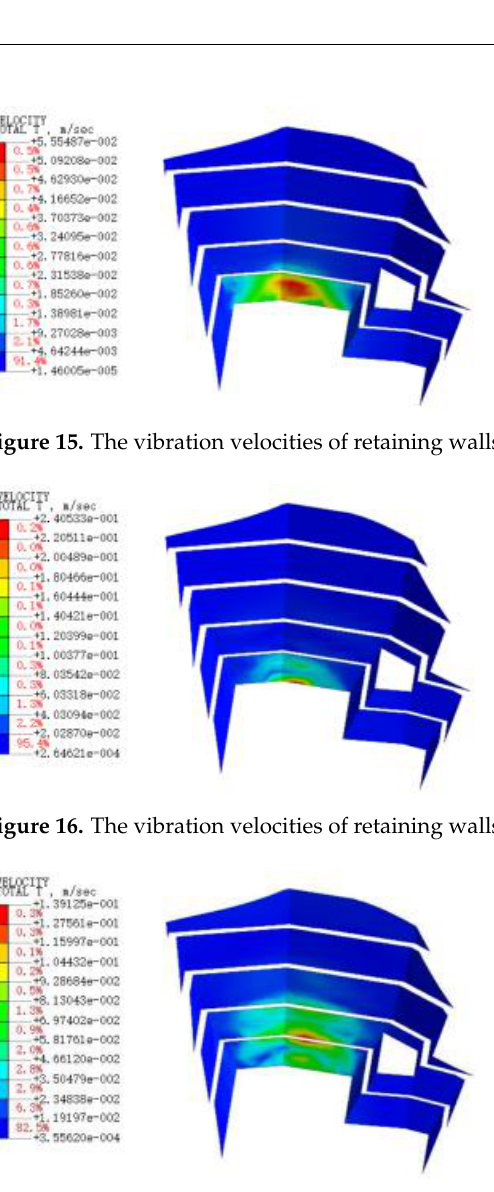
Figure 18. The vibration velocities of retaining walls at 300 ms.